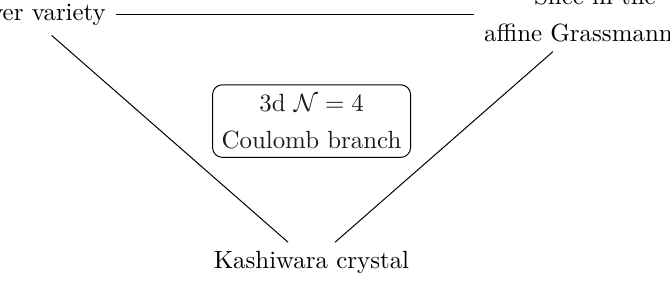
Figure 1 . Three realizations of 3d N = 4 Coulomb